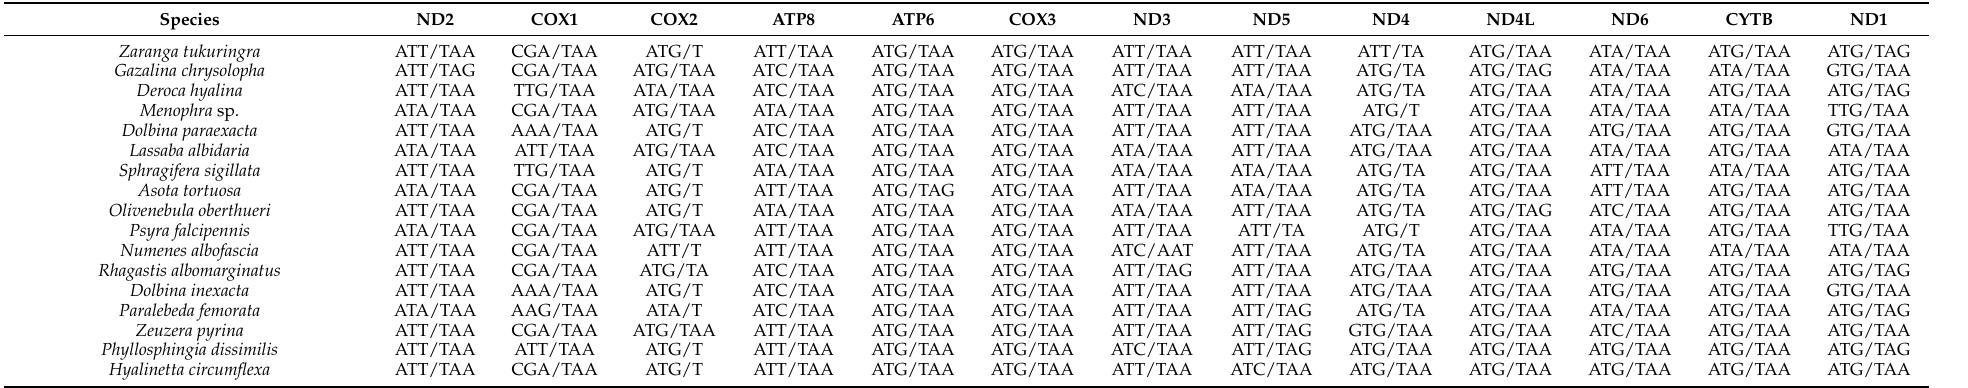
Table 3. The start and end codons of PCGs in 17